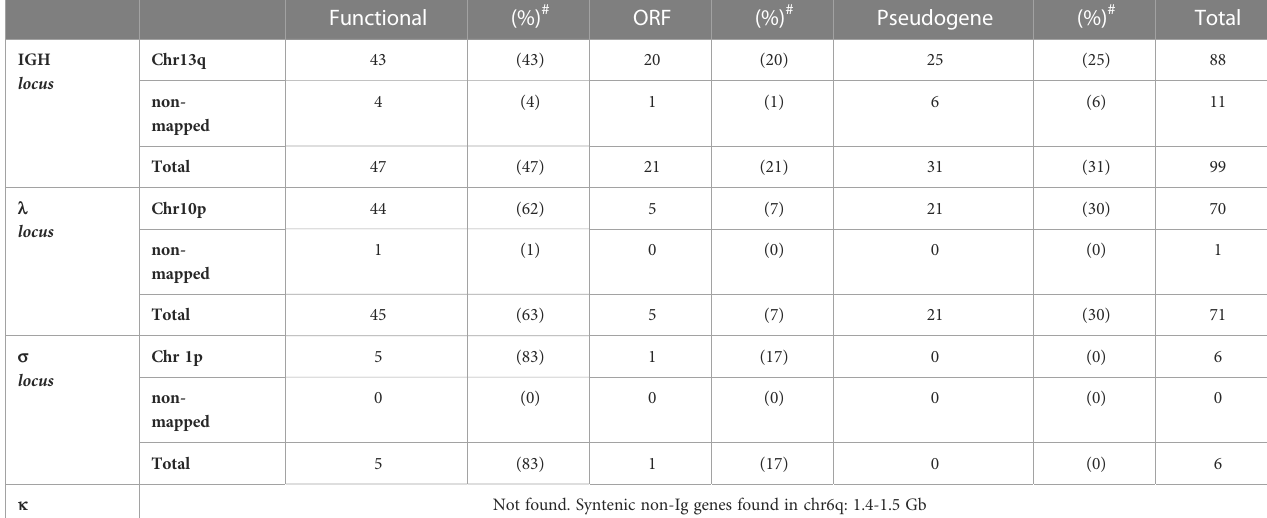
TABLE 1 Summary of IGHV and IGLV